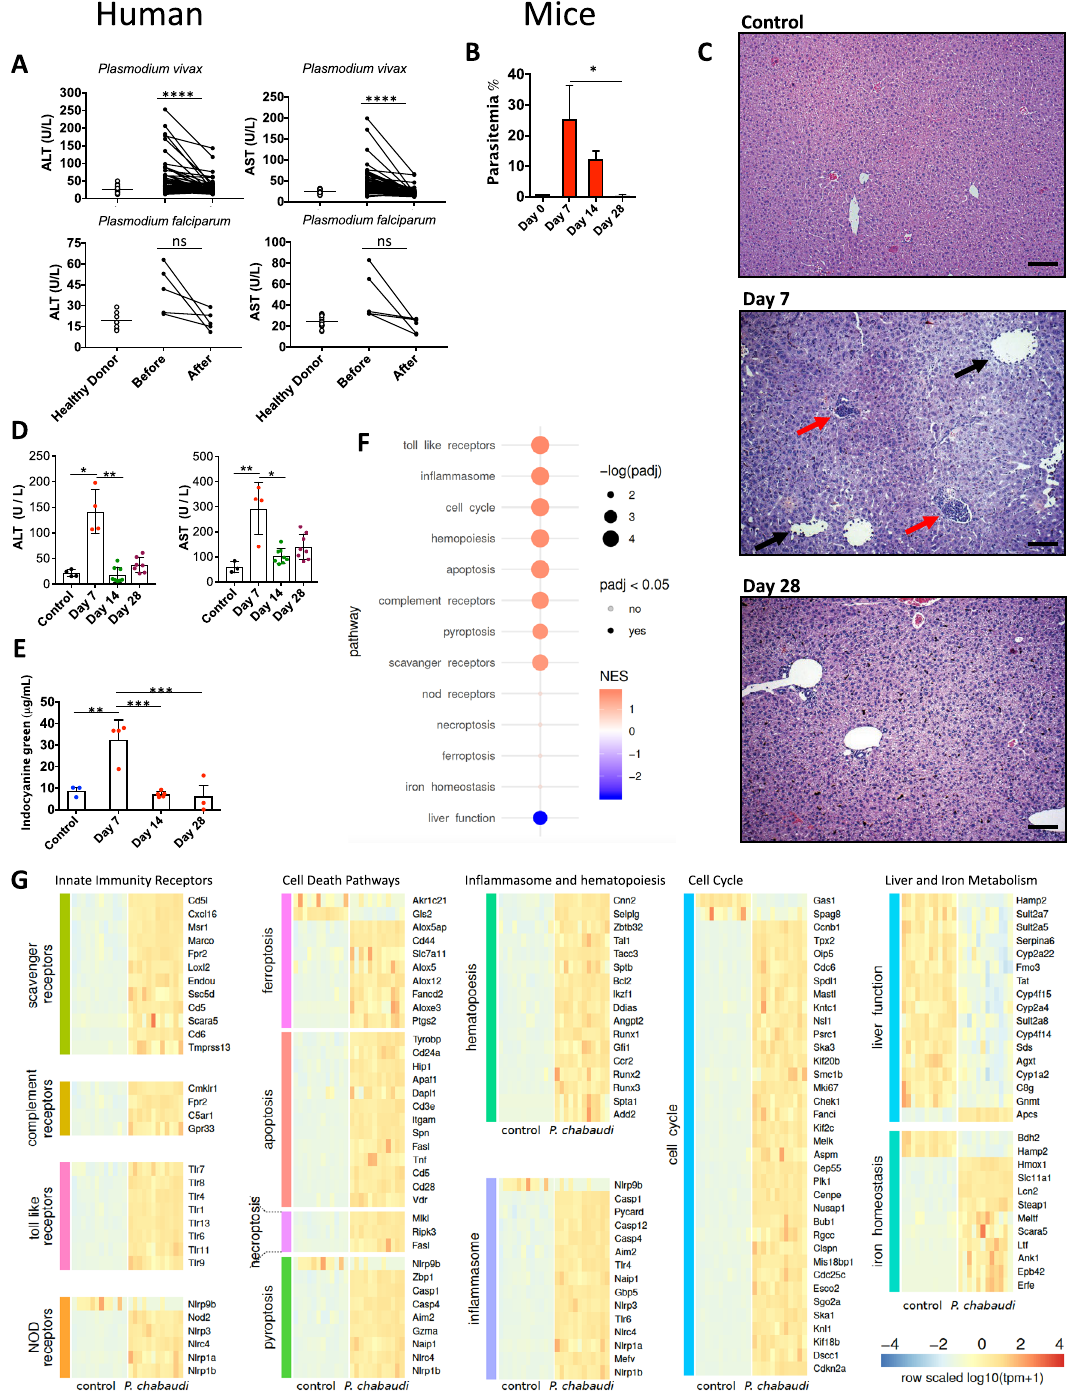
Figure 1. Liver injury during Plasmodium infection. ( A ) Human serum ALT and AST levels during acute phase and after treatment (control n = 16, P. vivax n = 54, P. falciparum n = 5). ( B ) Parasitemia (n = 6), ( C ) Liver histopathology (HE staining, Bar = 64 µm) and ( D ) Serum ALT and AST of control (n = 4) and infected mice at days 7 (n = 4), 14 (n = 8) and 28 (n = 8) post-infection. ( E ) Liver dysfunction during different times of infection (n = 3–5). ( F ) Genetic analysis of different pathways related to liver inflammation. ( G ) Heatmap of differential expression of genes involved in inflammation. Color scheme represents the global Z score . The data shown are representative of 3 independent experiments. Results expressed as mean ± SD. Statistical significance comparing infected and non-infected mice (Kruskal–Wallis test, * p < 0.05, ** p < 0.01, *** p < 0.001, **** p <